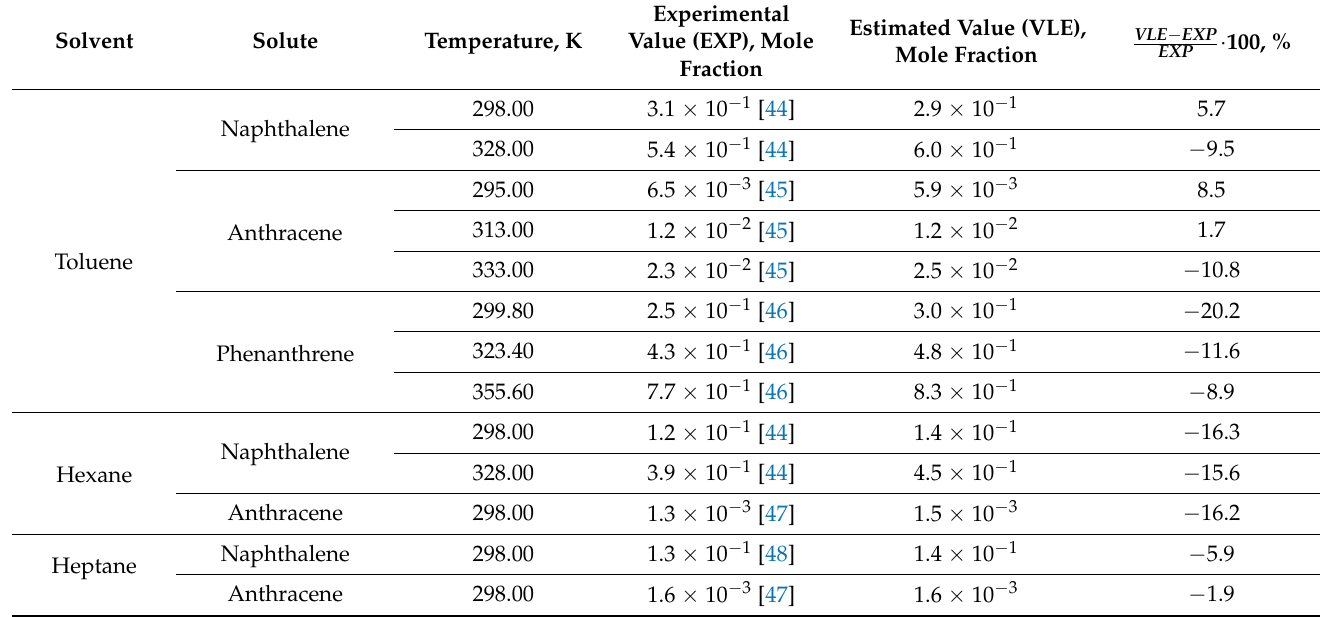
Table 1. Calculated and experimental values of solubility (mole fractions) of PAHs in hydrocarbons at various